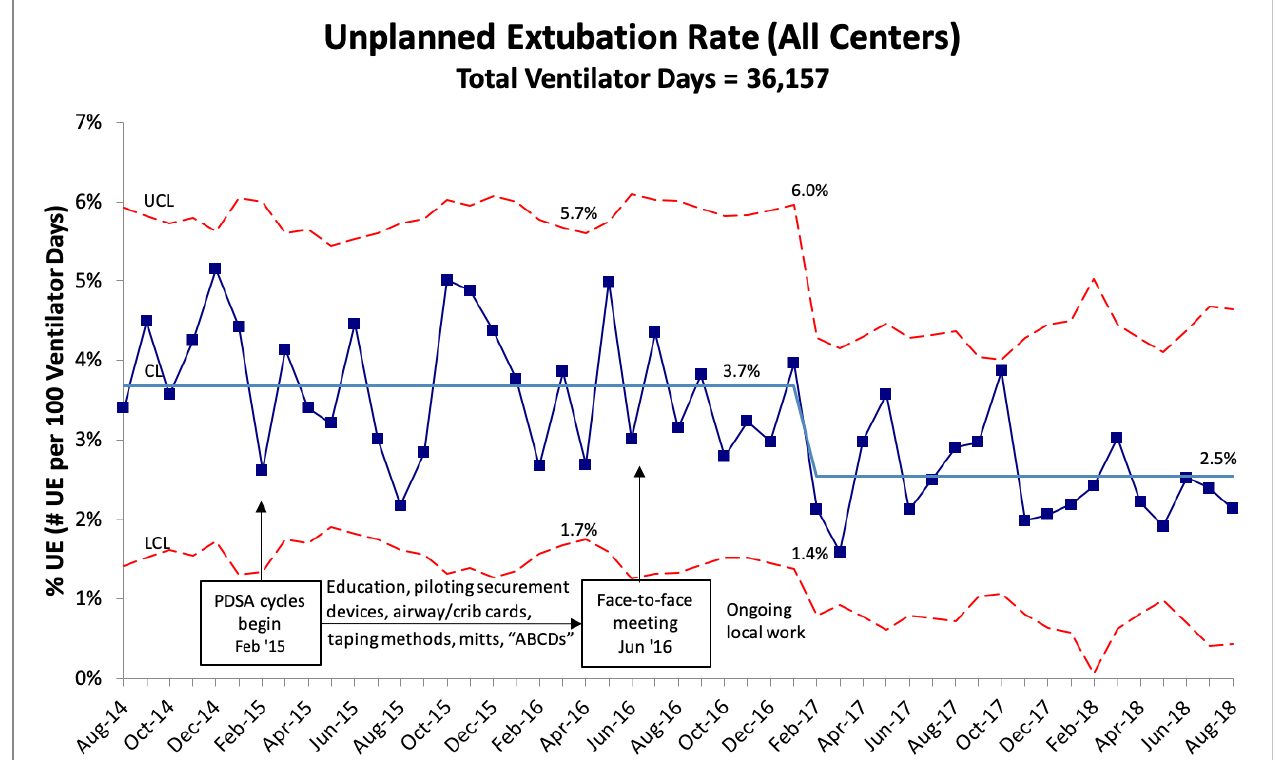
Figure 3. U-chart demonstrating the monthly combined UE rate for all centers. Special cause variation (rule of shift) was noted beginning in February 2017. CL = center line (mean), UCL = upper control limit, and LCL = lower control limit.